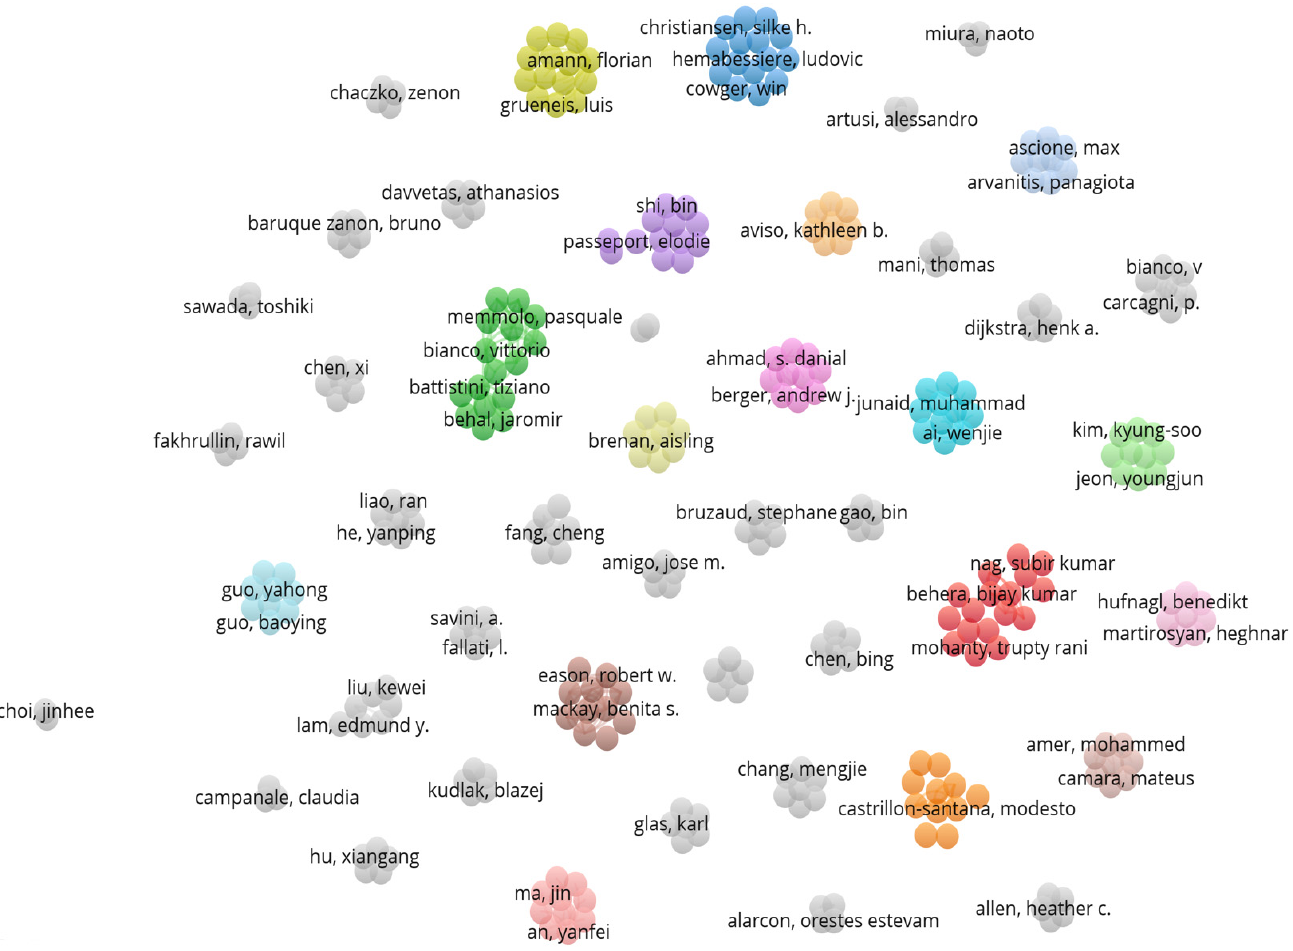
Figure 12. Closest collaborative relationship of authors (visualized with VOSviewer) by setting the threshold to